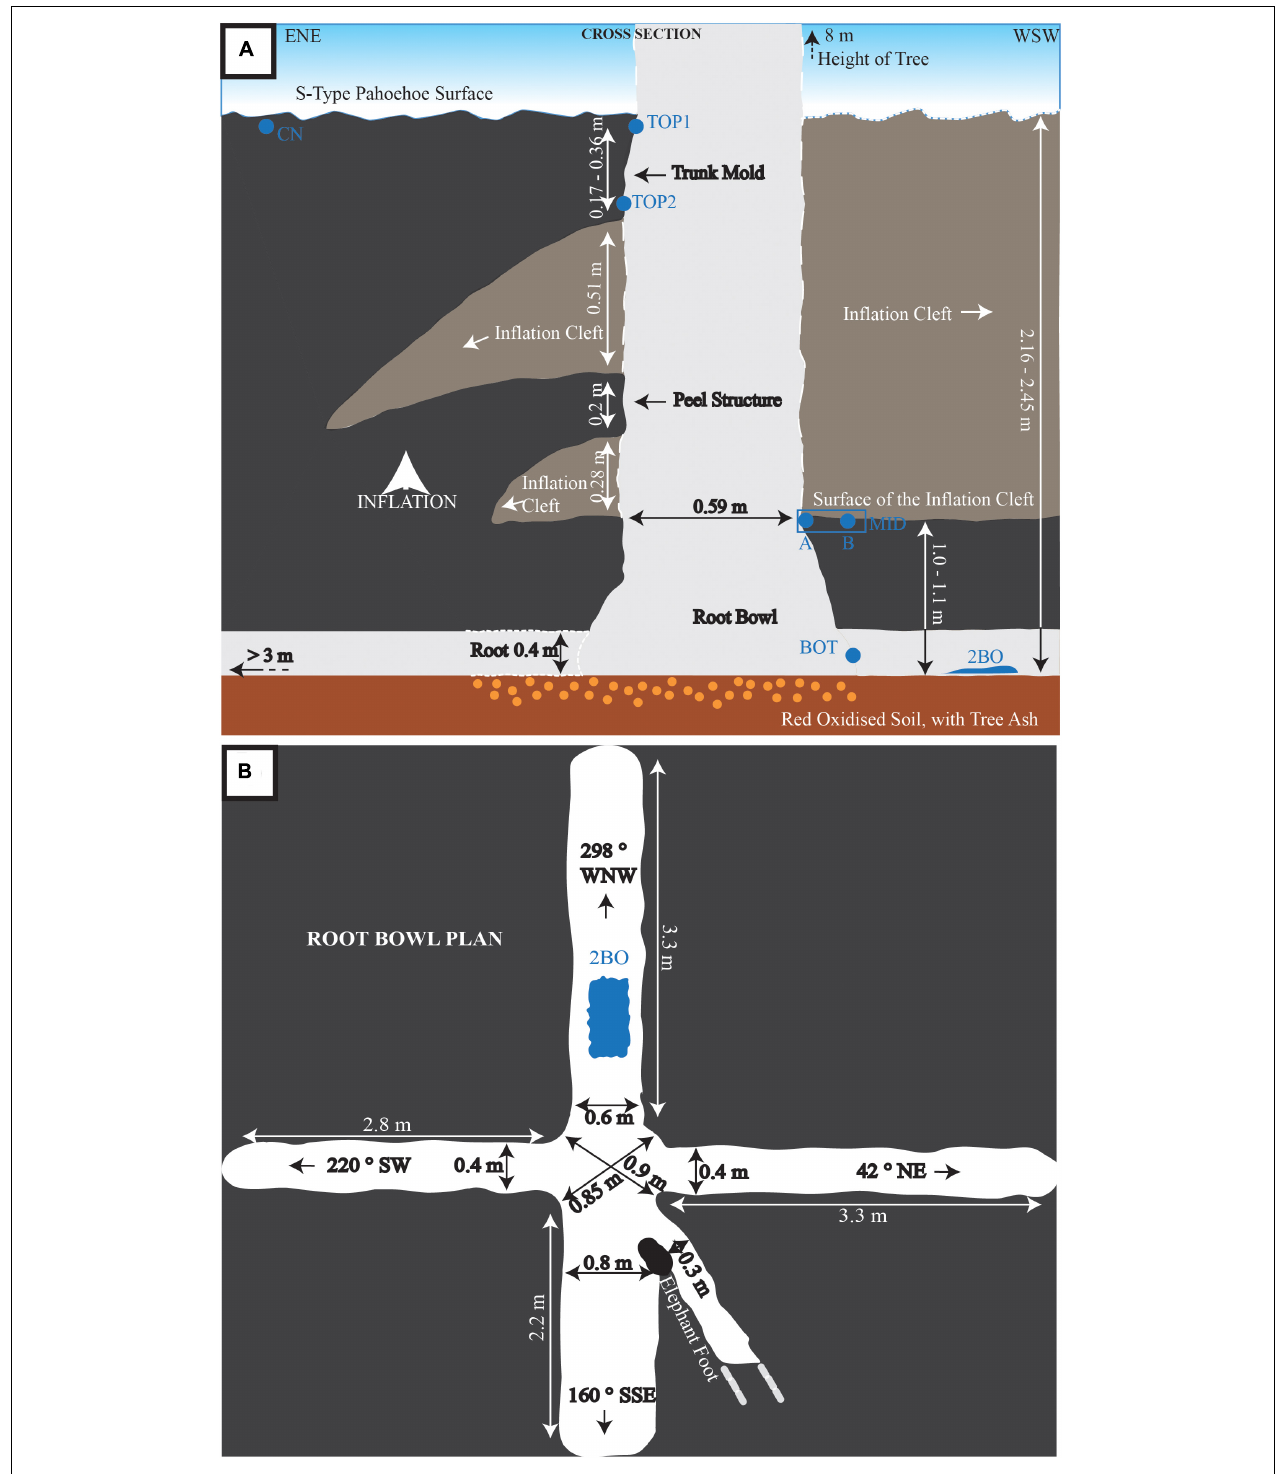
FIGURE 4 | (A) Plan in vertical section of the studied tree mold and its inflation cleft (light brown). In blue are the sample locations. The area once occupied by the standing of tree and its root system is given in gray, and new lava is black. Orange dots denote location of tree ash. (B) Plan in basal cross section of the root bowl.